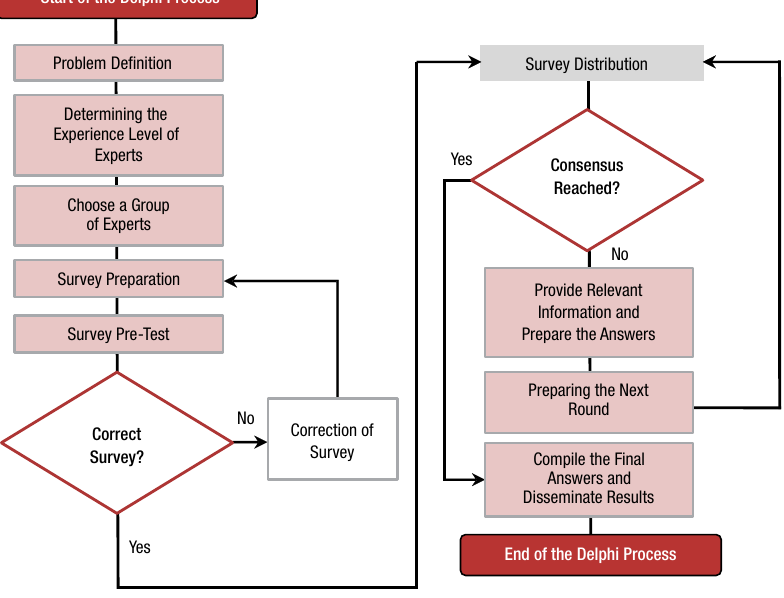
Fig. 3. Operational structure of the Delphi technique Source : Zapata in Ferreira (2003, adap.).